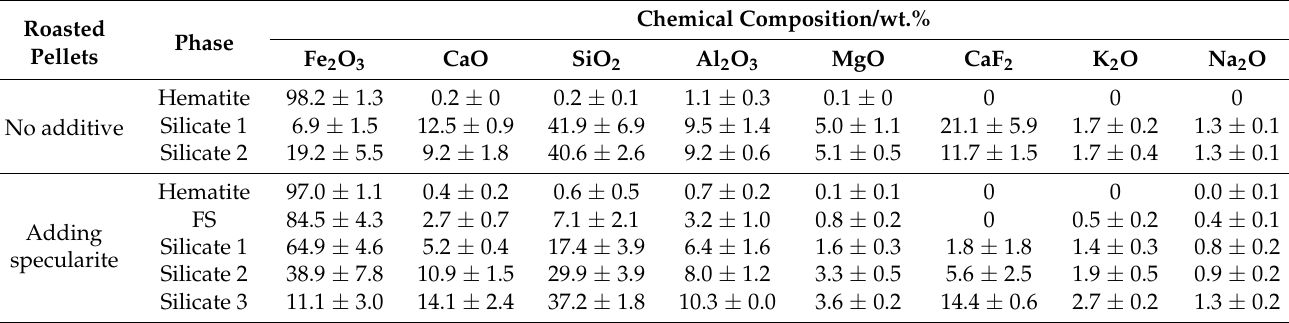
Figure 9. EDS analysis of roasted fluorine-bearing iron concentrate pellets with no additive ( a ) and adding specularite ( b ) (preheating at 920 °C for 16 min and roasting at 1080 °C for 10 min). Table 5. Chemical compositions of the phases marked in Figure 9 in the roasted pellets.